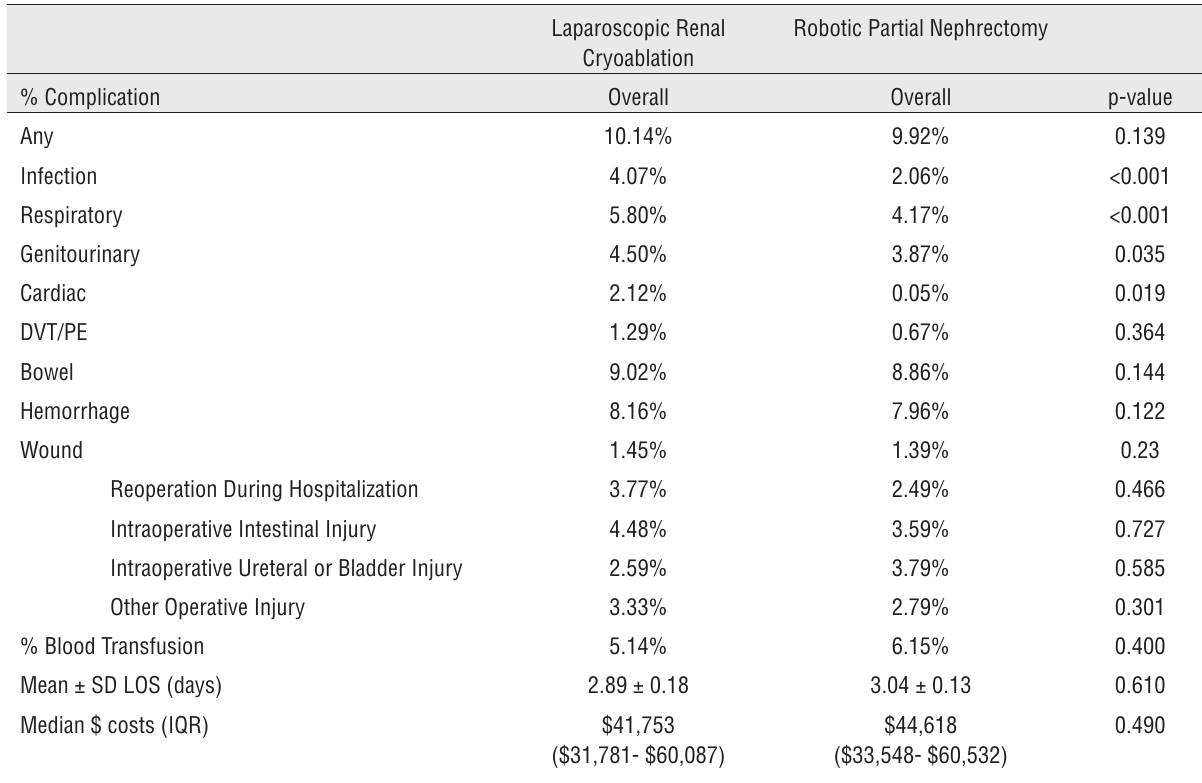
Table 2 - Complications by Surgical Approach for the Treatment of Small Renal Masses.